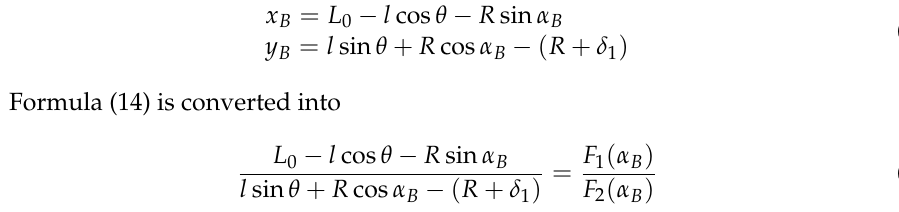
( b ) Figure 12. Schematic diagram of installation clearances of the variable stiffness actuator. ( a ) The initial state. ( b ) The critical position of the roller contacting with the leaf spring on one side. The working state of the actuator is analyzed in the following two situations.